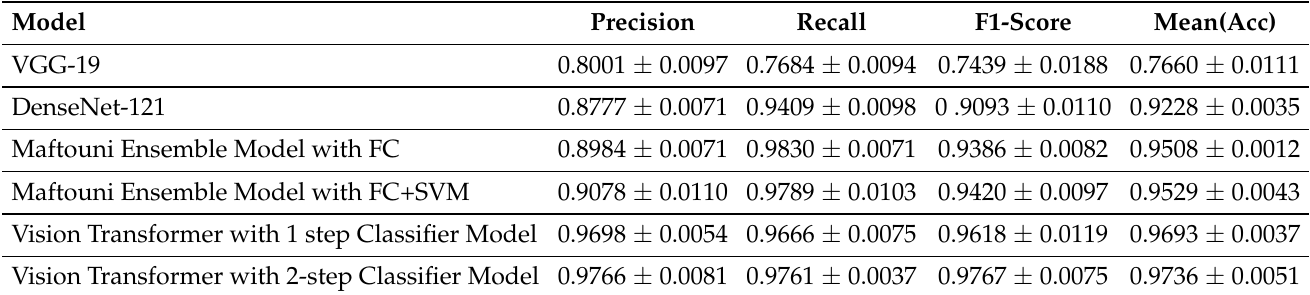
Table 1. Representation of average model performance with standard